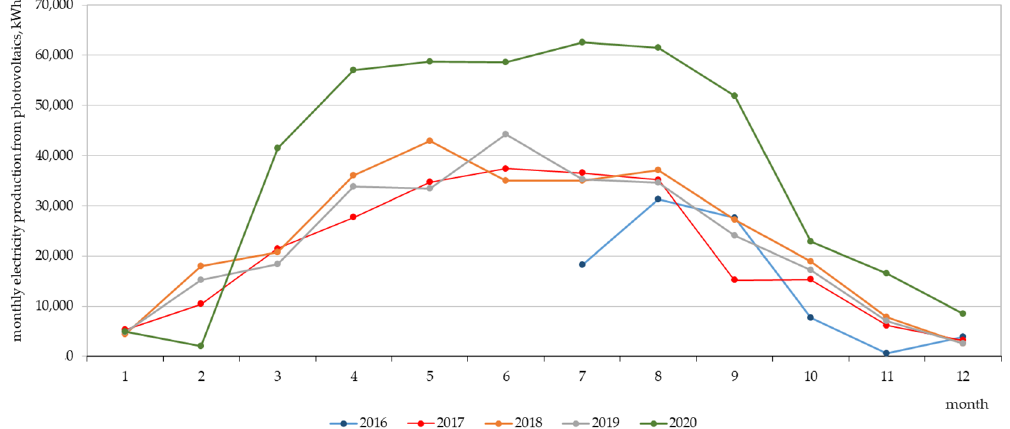
Figure 6. Monthly photovoltaic electricity production.